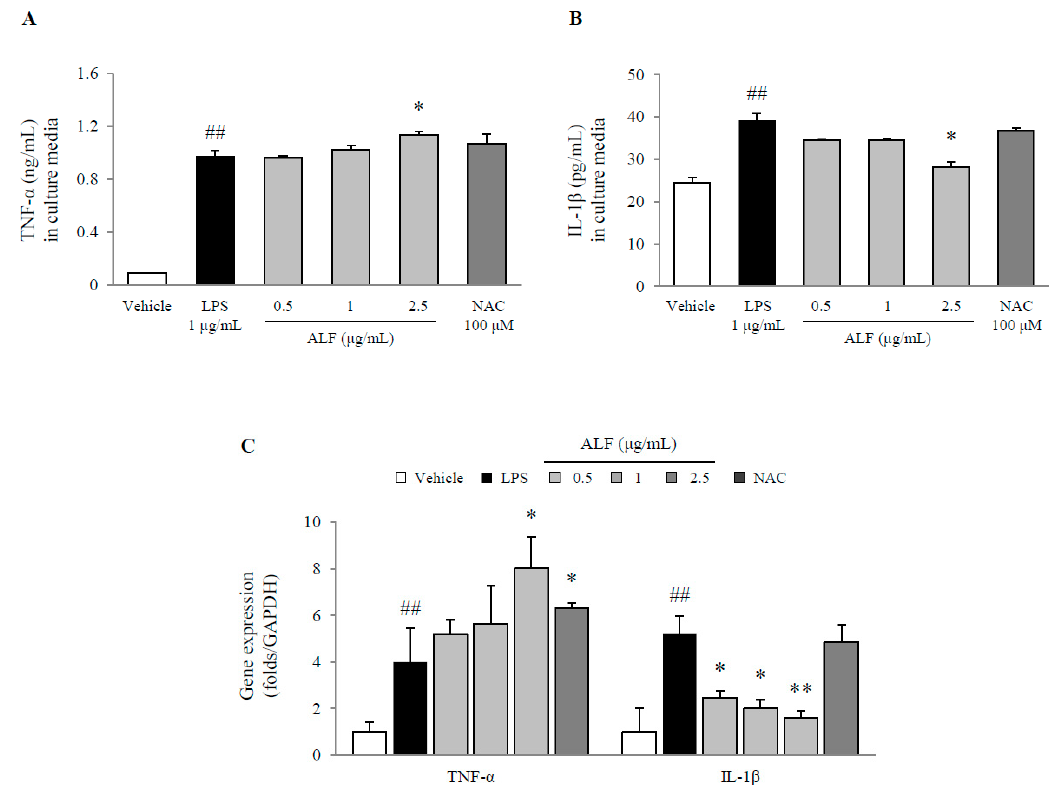
Figure 5. Tumor necrosis factor (TNF)- α and interleukin (IL)-1 β levels in BV2 cells. Proinflammatory cytokines TNF- α ( A ) and IL-1 β ( B ) in the cell supernatant and gene expression relative to GAPDH ( C ) in the cell lysate were determined using ELISA ( n = 6) and real-time PCR ( n = 3), respectively. The data are expressed as the mean ± SD. ## p < 0.01 compared with the vehicle-treated cells; * p < 0.05 and ** p < 0.01 compared with the LPS-treated BV2 cells.